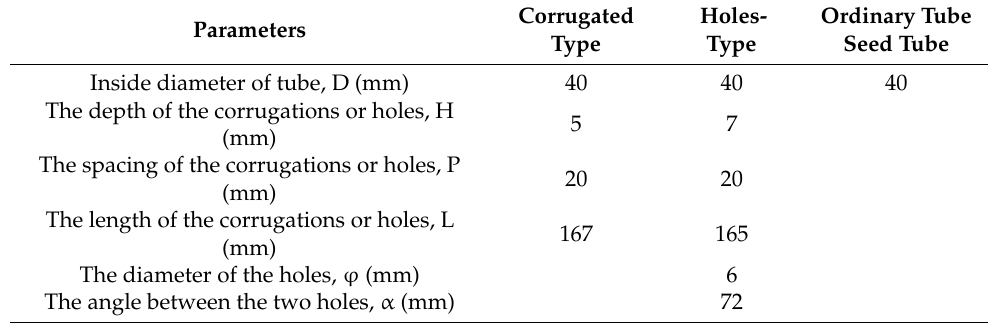
Figure 3. Diagram of hole-type pipe. Table 1. Dimensional configurations of the tubes.